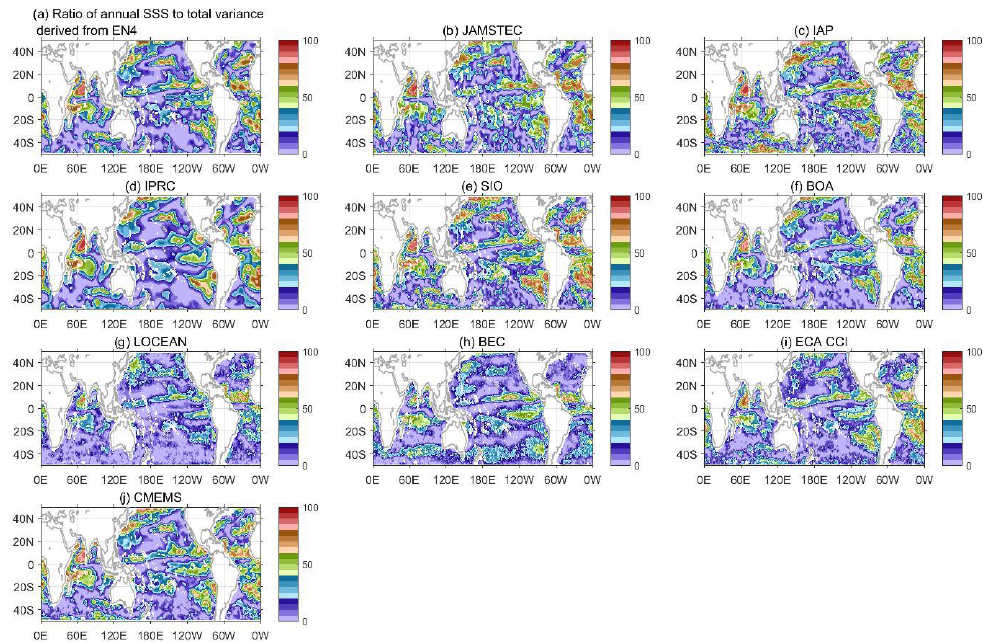
Figure 9. Percentage of total SSS variance explained by annual variability.